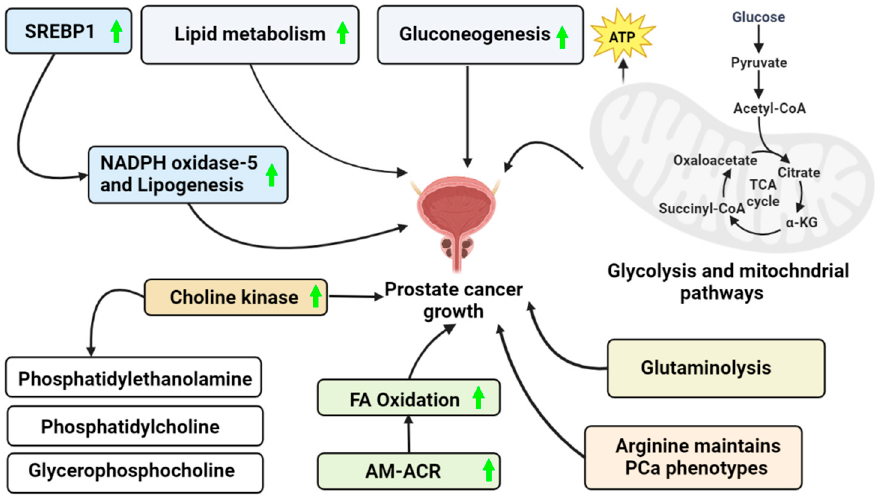
Figure 1. PCa growth via a different mechanism. This figure represents the possible ways to acquire the energy required to maintain PCa cell survival in an ATP-depleted cell environment. (Green ar- row—Upregulation).